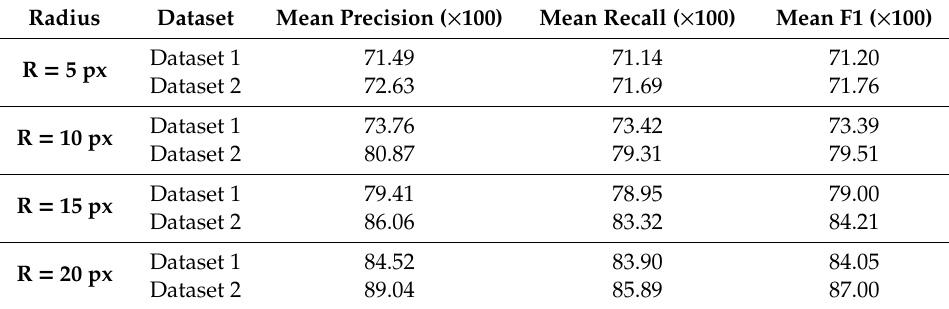
Table 5. Plant detection evaluation results based on generating a binary detection map for investigated image